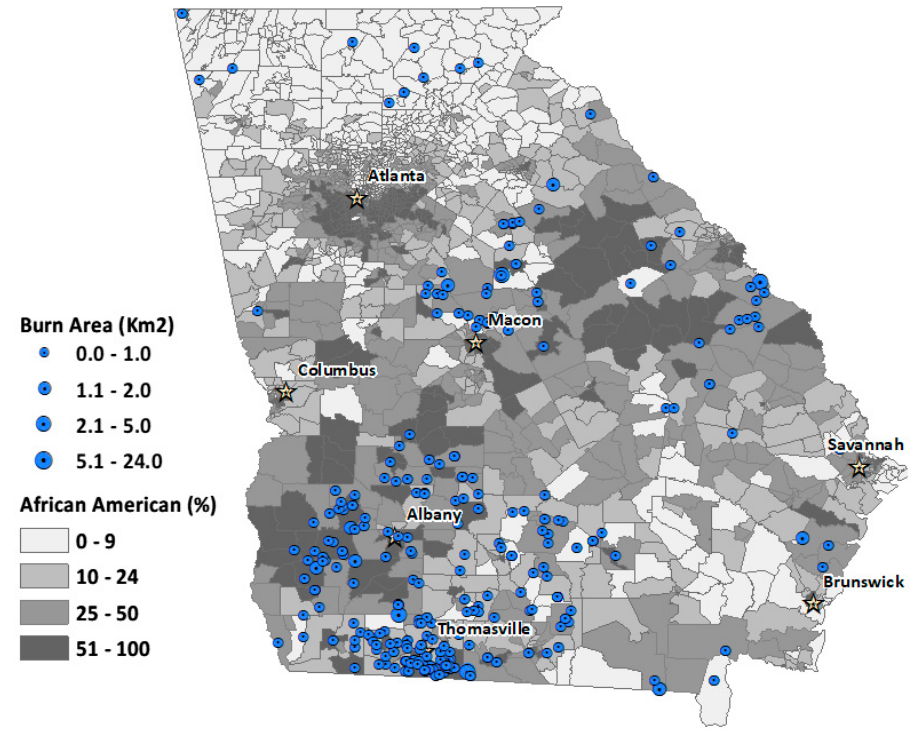
Figure 5. Spatial distribution of burn permits for commercial land exceedance days, overlaid with percent African American population for Georgia census tracts. Circles denote the relative burn area size for each permit.